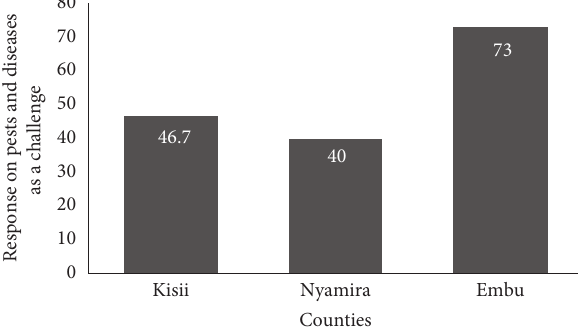
Figure 10: Pests and diseases as a challenge in banana farming.